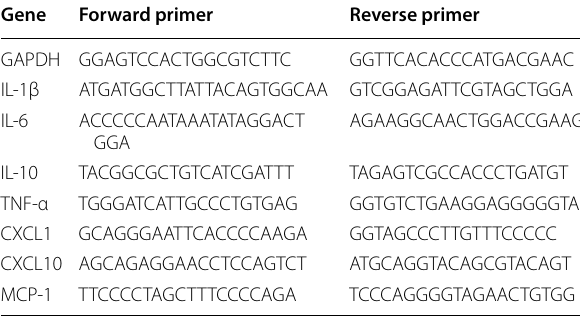
Table 2 Human primer sequences for the real-time PCR